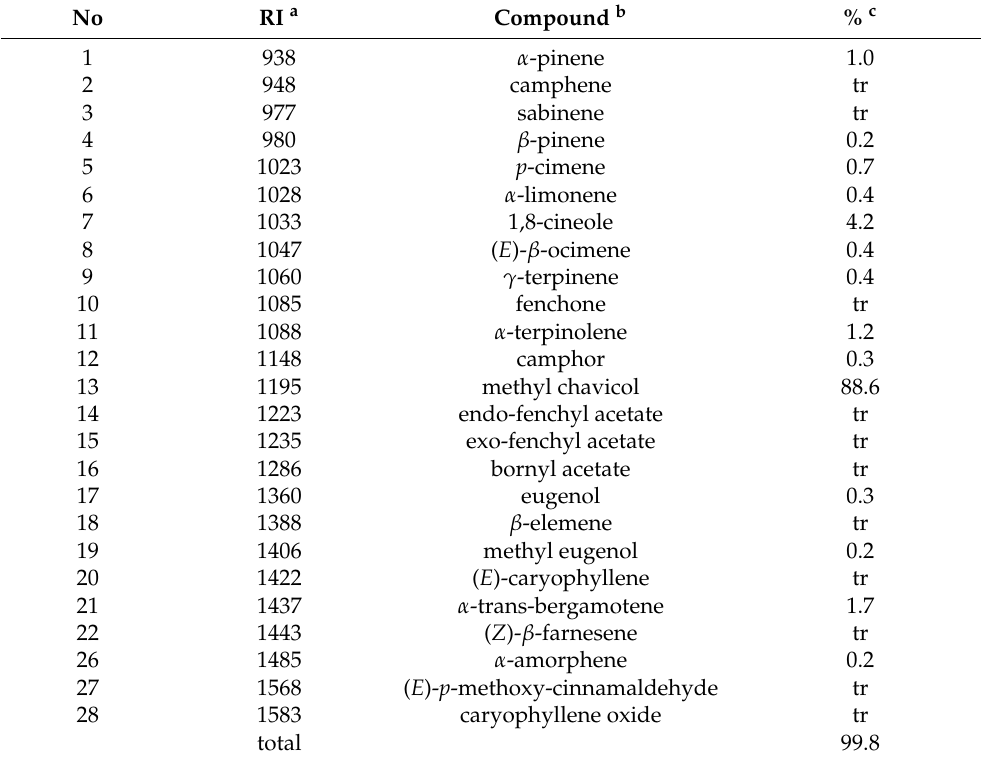
Table 1. Chemical composition of essential oil from Ocimum basilicum